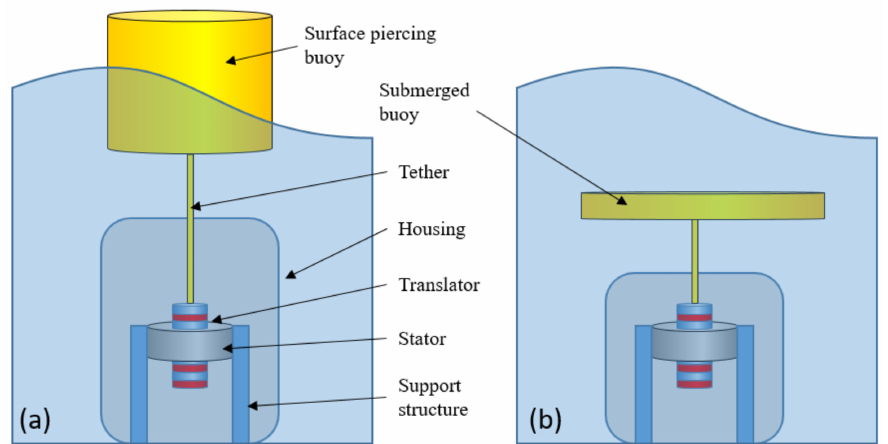
Figure 1. Example direct-drive wave energy devices coupled to a linear electrical generator. ( a ) Sur- face piercing buoy with restoring spring force; ( b ) fully submerged buoy with constant